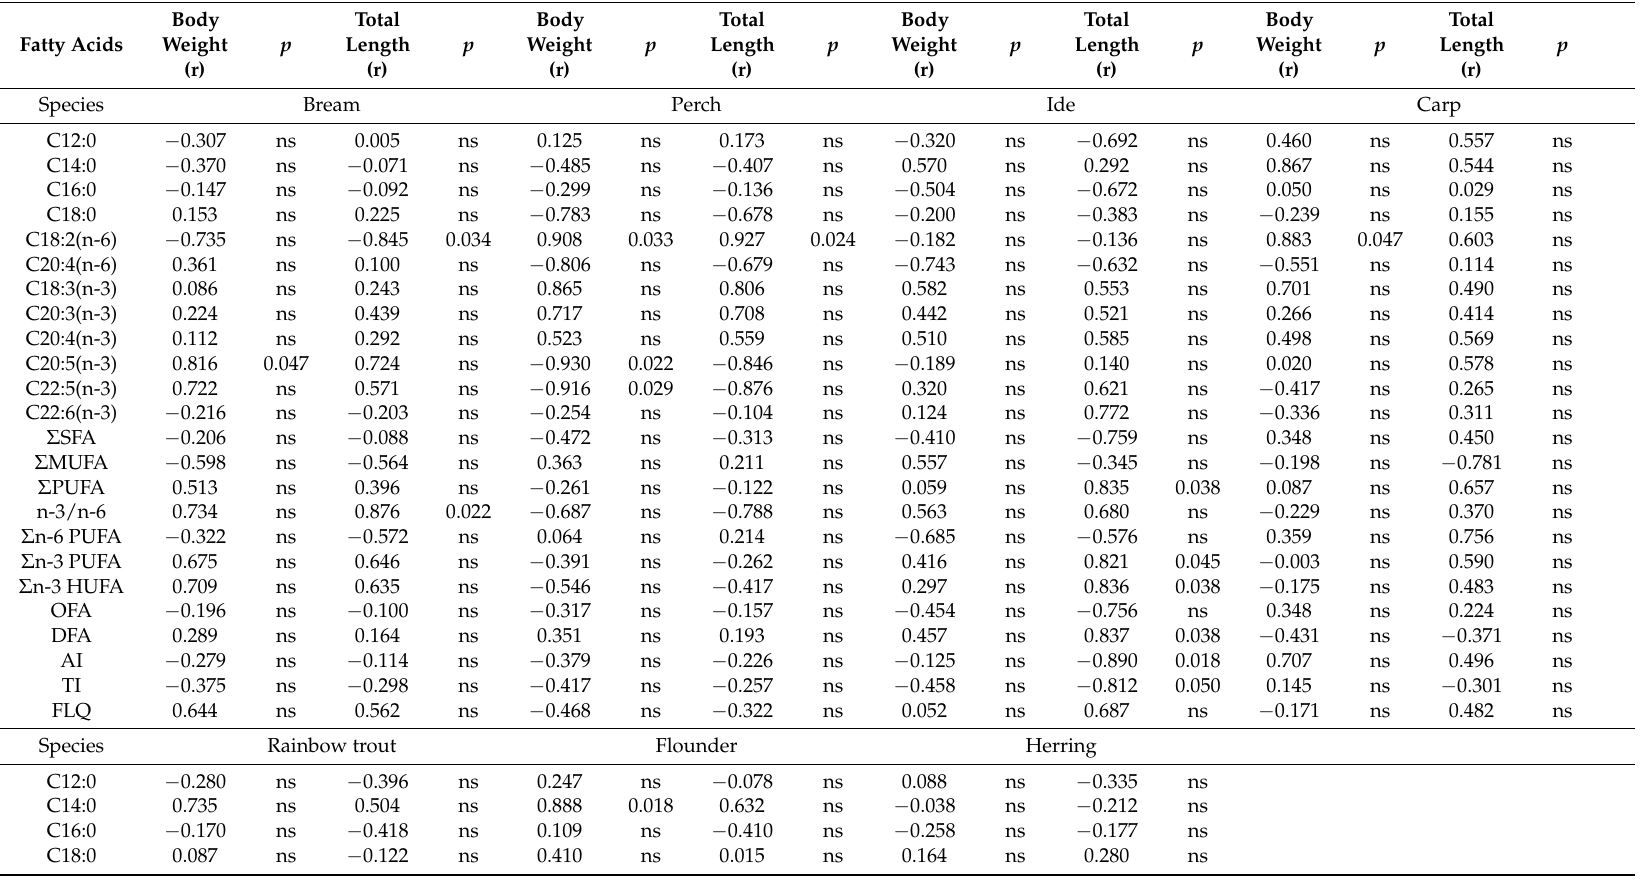
Table 3. Linear correlation coefficients (r) between fatty acids content in muscles of fish and body weight or total